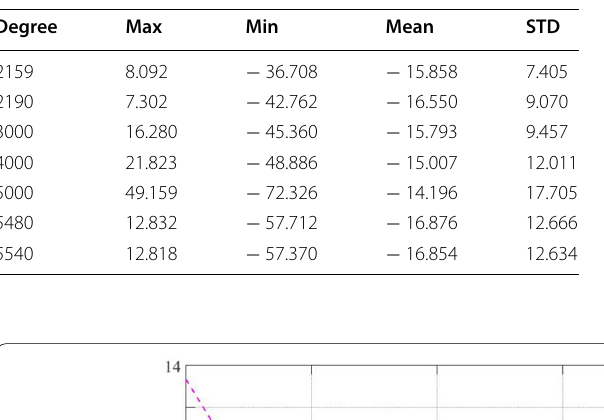
Table 8 The statistics of the differences between the gravity anomaly derived from XGM2019e with different truncated degrees and the measured data in Sichuan Basin without terrain correction (unit: mGal)